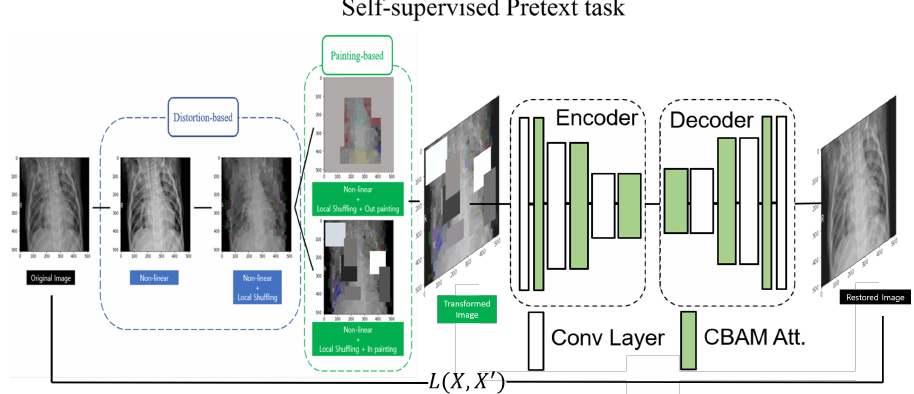
Figure 4. The modified Models Genesis with CBAM.